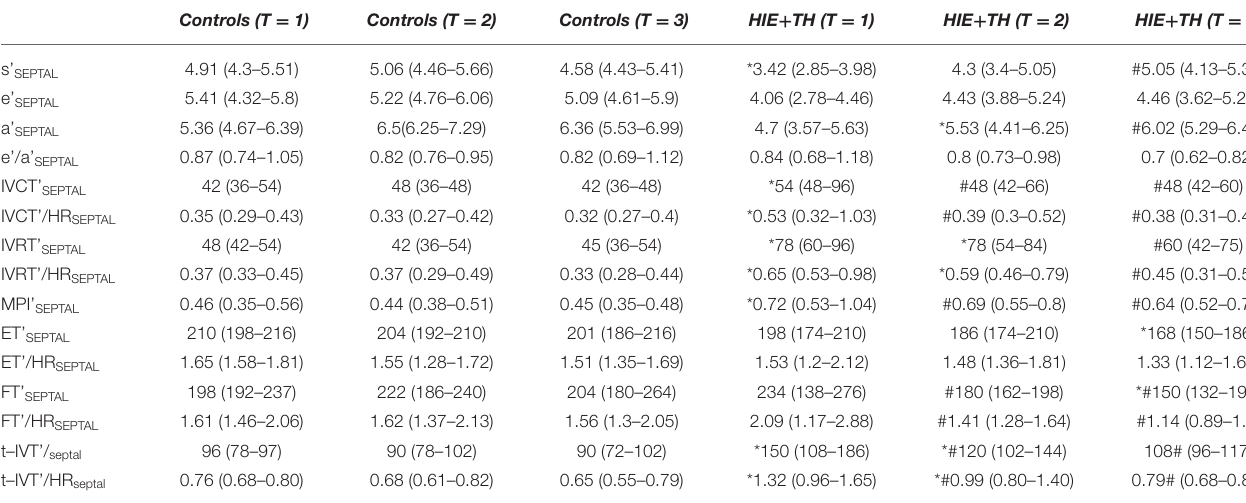
TABLE 4 | TDI data from the interventricular